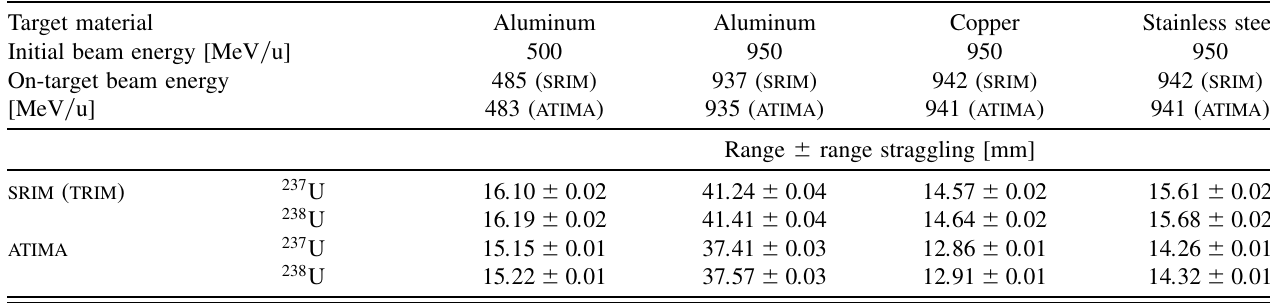
TABLE II. Range and range straggling of the 237 U and 238 U beams in aluminum, copper, and stainless-steel targets calculated by SRIM2011.06 (Monte Carlo module TRIM ) and ATIMA1.2 . In these calculations, both isotopes were transported as primary ions. The initial energy of the primary ions was 500 and 950 MeV = u , no momentum spread. Energy losses of the primary beam in the vacuum window, air gap, and SEETRAM were taken into